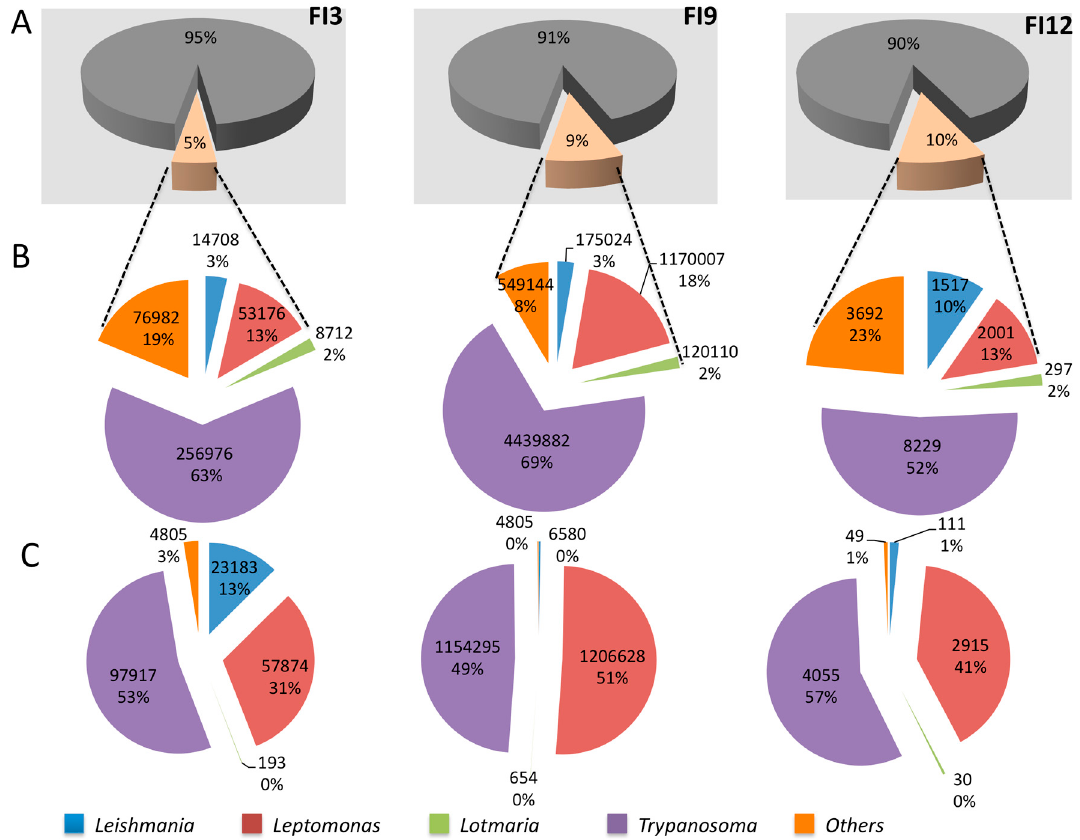
Figure 2. Composition of gut microbiota for the three Andean mummies studied by Santiago-Rodriguez et al. [1]: FI3, FI9, and FI12, respectively. ( A ) Proportion of reads assigned to the Trypanosomatidae family for each mummy after analysis with Kraken. Reads not matching Trypanosomatidae sequences appear in grey. Reads matching Trypanosomatidae sequences are flesh colored; ( B ) In Trypanosomatidae : numbers and percentages of reads assigned to the genera Trypanosoma (purple), Leishmania (blue), Leptomonas (red), Lotmaria (green). Reads from mummies FI3, FI9, and FI12 matching to any other Trypanosomatidae are shown in orange; ( C ) Results obtained by the Bowtie2 alignment sequence for mummies FI3, FI9, and FI12, respectively. For facility in comparison of the results gathered with both software the same color reference was used.